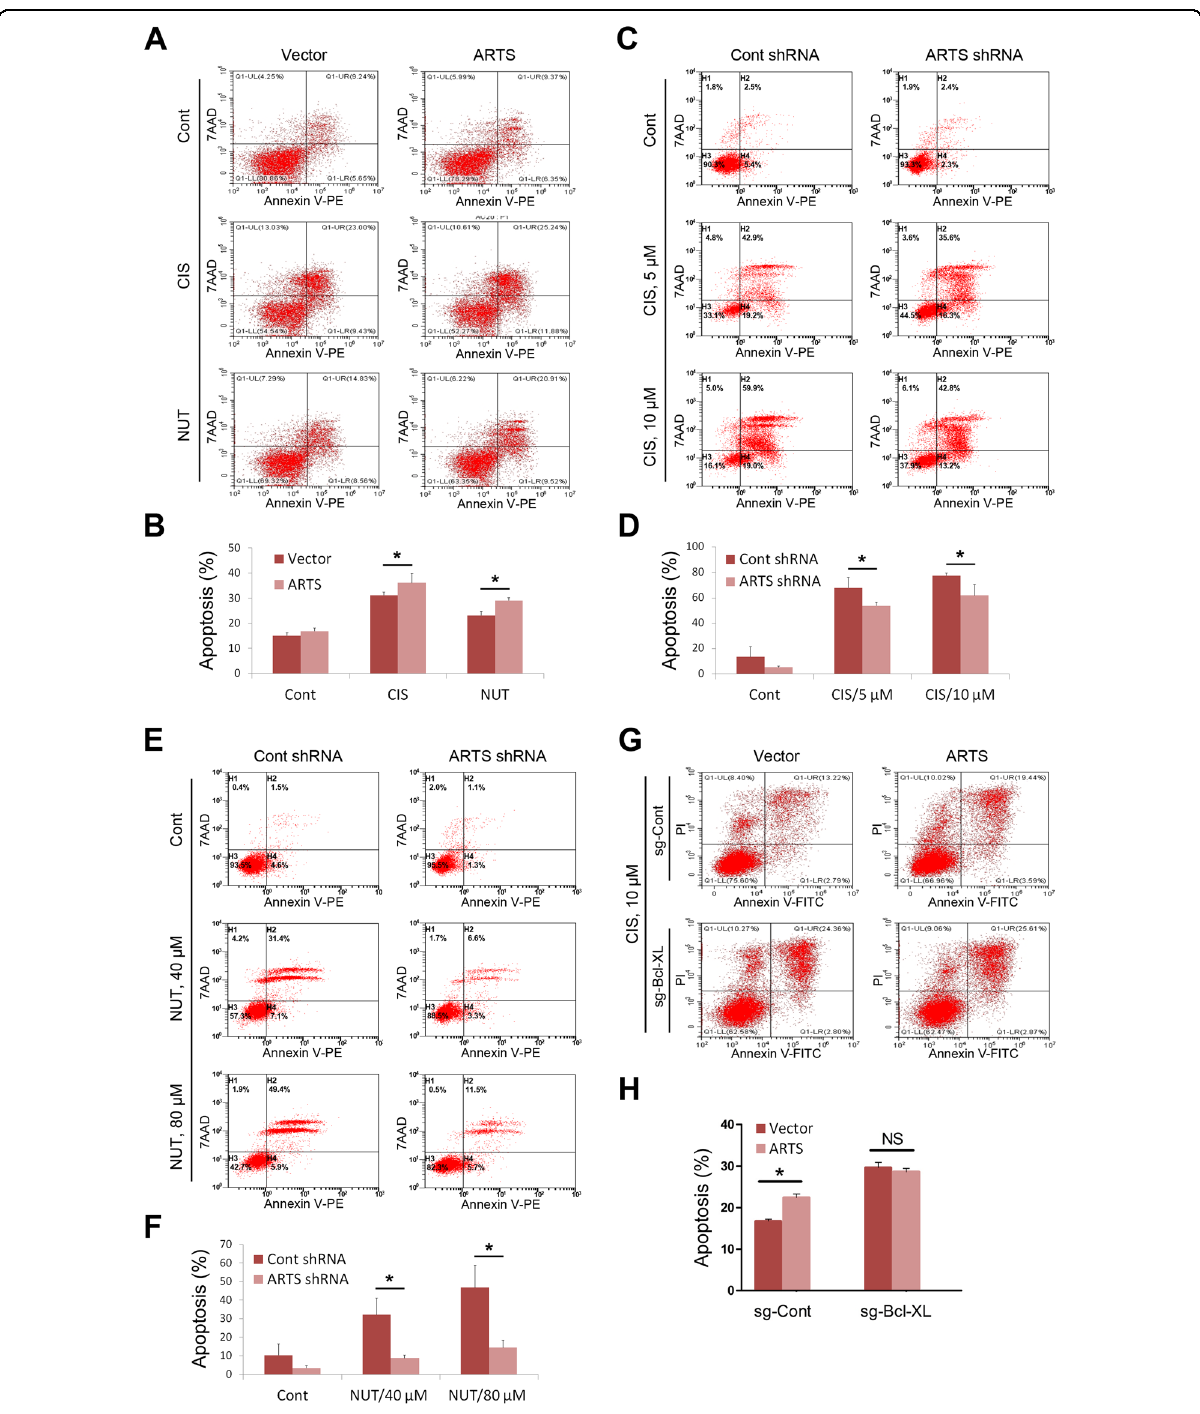
Fig. 6 ARTS promotes apoptosis in cooperation with p53. A , B Overexpression of ARTS signi fi cantly augments Cisplatin- or Nutlin-3-induced apoptosis. HCT116 p53 + / + cells stably overexpressing the vector or ARTS were treated with 20 μ M Cisplatin or 10 μ M Nutlin-3 for 48 h. The apoptosis of the treated and untreated control cells were then analyzed by fl ow cytometry. C , D Ablation of ARTS diminishes Cisplatin-induced apoptosis. H460 cells stably expressing control or ARTS shRNA were treated with 0, 5, or 10 μ M Cisplatin for 48 h and subjected to fl ow cytometric analysis for apoptosis. E , F Ablation of ARTS markedly impairs p53-induced apoptosis. H460 cells stably expressing control or ARTS shRNA were treated with 0, 40, or 80 μ M Nutlin-3 for 48 h and subjected to fl ow cytometric analysis for apoptosis. G , H Depletion of Bcl-XL impairs ARTS-induced apoptosis in response to Cisplatin treatment. The control and Bcl-XL-knockout HCT116 p53 + / + cells were transfected with the control vector or ARTS-expressing plasmid and treated with Cisplatin for 48 h, followed by fl ow cytometric analysis for